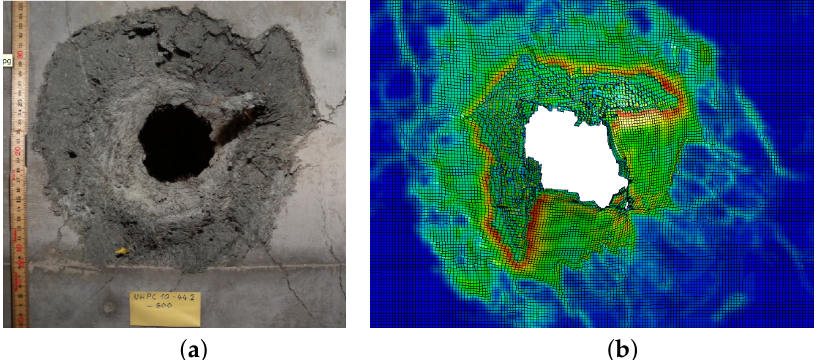
Figure 9. Experimental ( a ) and numerical reconstruction ( b ) of structural test using the finite element method and the DAMP material model (courtesy of armasuisse